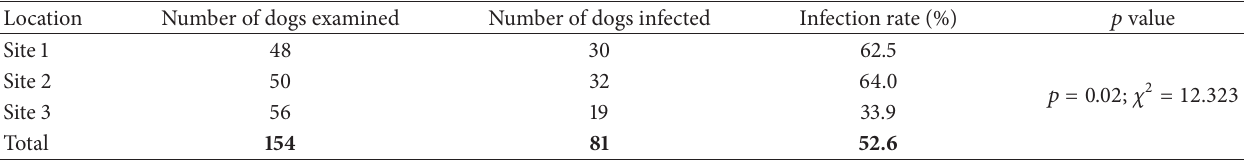
Table 4: Prevalence of helminths based on location of dog.